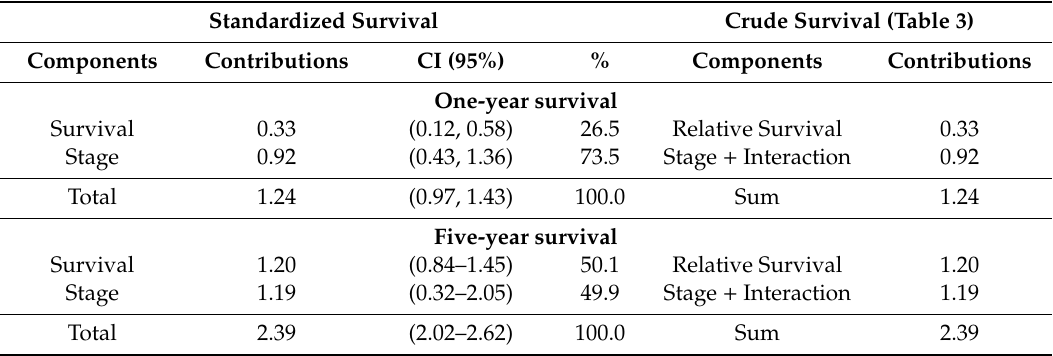
Table 4. Decomposition of the di ff erence in breast cancer one-year and five-year survival standardized (by age and background survival) between Zealand than in Central Denmark, 2008–2010. Standardized Survival Crude Survival (Table